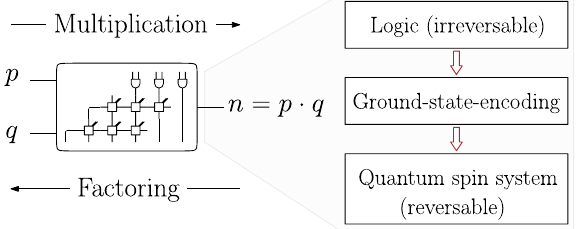
Fig. 1 General idea. By introducing reversible gates, factorization is considered a reverse multiplication. The problem is reformulated as an optimization problem by encoding the logic in the ground space of a spin